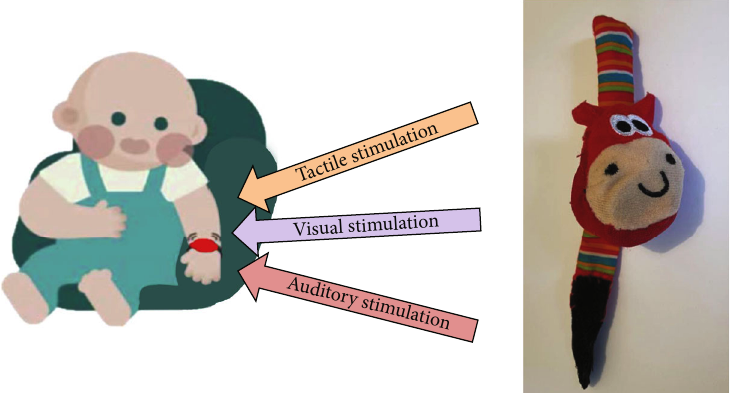
Figure 2: MuSSAP training. In the MuSSAP training, the infant wears a multisensory stimulating wristband (with simultaneous rhythmic visual (led lights), auditory (song), and tactile (vibration) stimuli) to increase attention for the contralesional upper limb. The multisensory wristband worn by the infants in the study is presented in the photo on the right